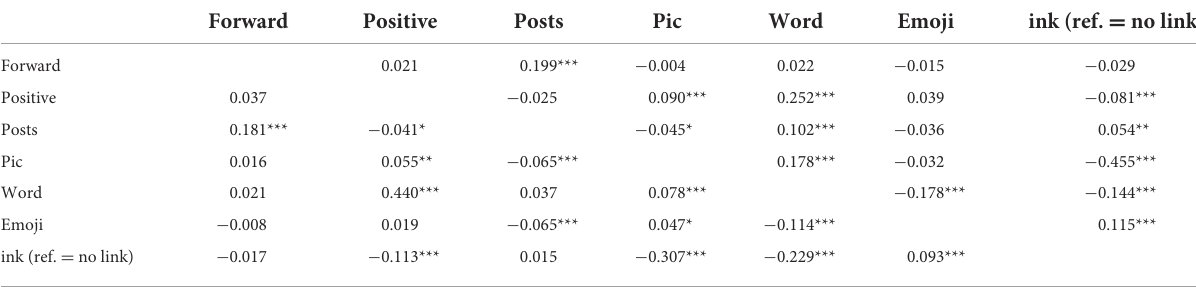
TABLE 10 Bivariate correlation analysis of positive sentiment regression model.